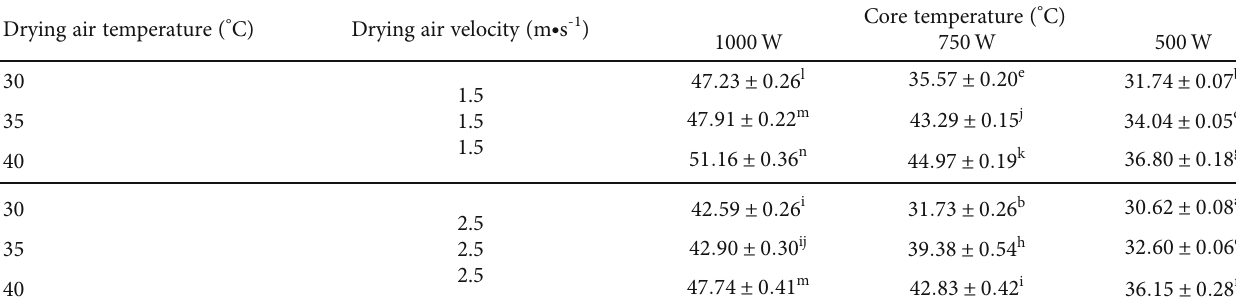
Table 3: Average core temperature of the beef sample.